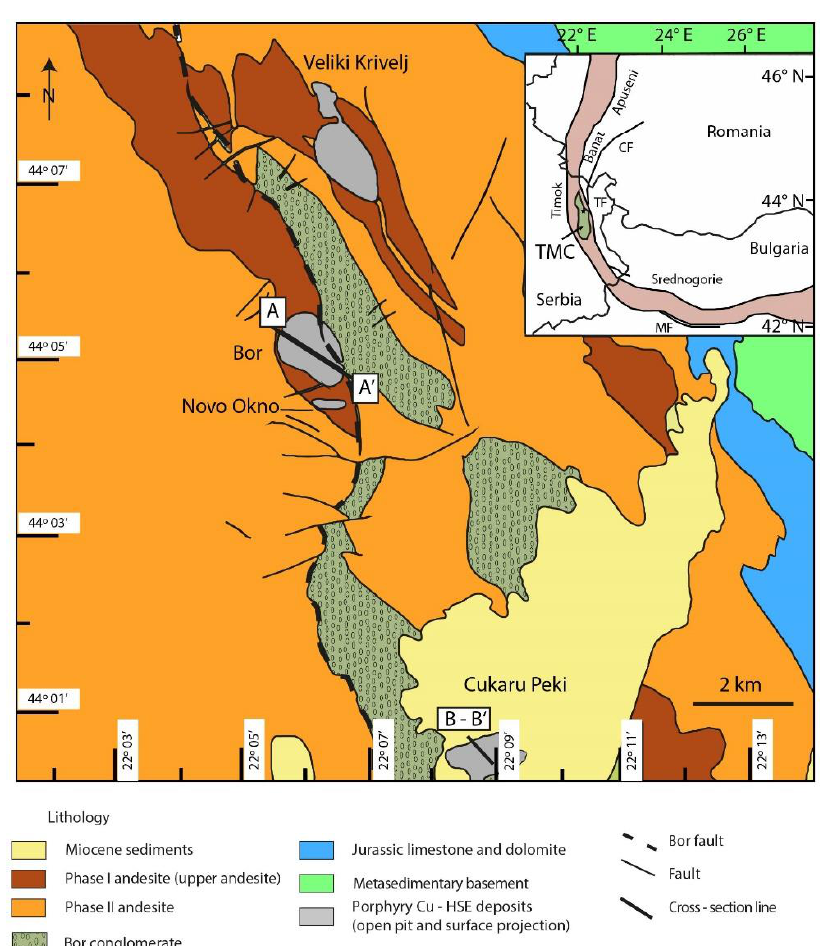
Figure 1. Geological map of the South-Eastern Timok magmatic complex (TMC), with locations of Bor and Cukaru Peki deposits. Modified after [6,8,9]. Lines A—A’ and B—B’ mark the position of the deposit sections through Bor and Cukaru Peki in Figure 2.